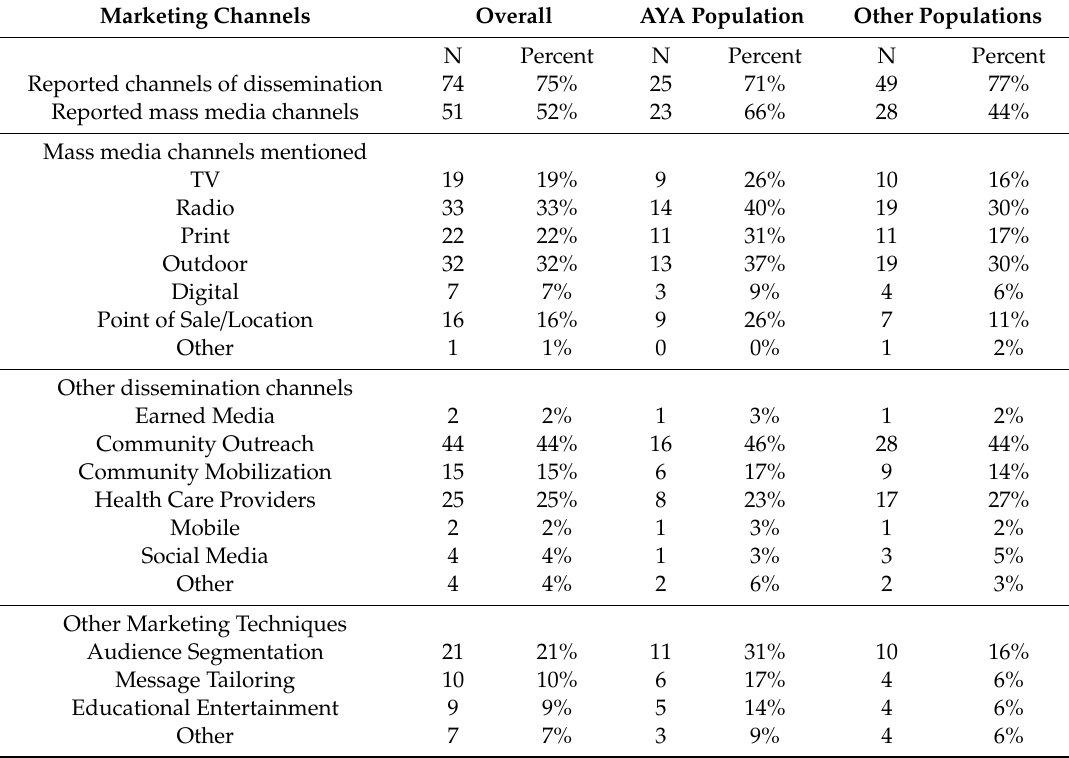
Table 2. Marketing